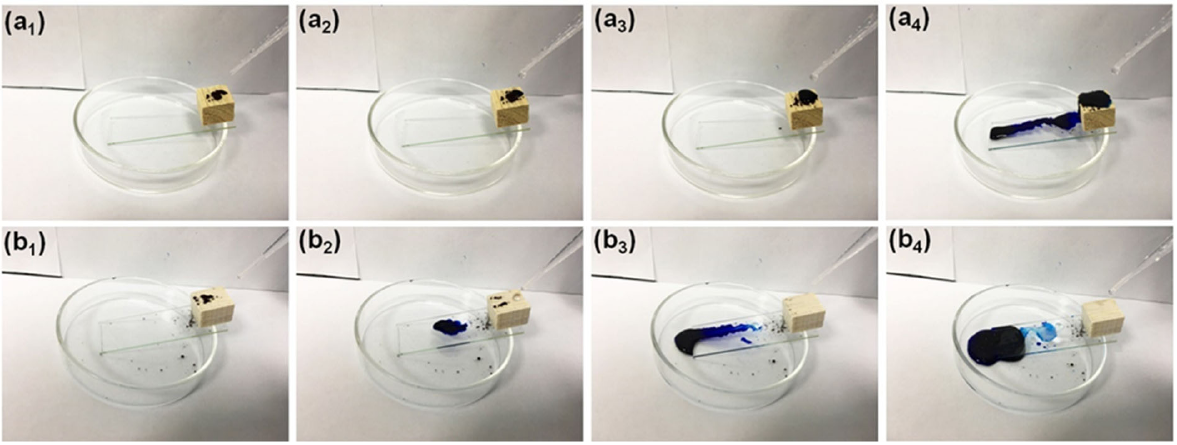
Figure 7. Wood self ‐ cleaning test before (a 1 ‐ a 4 ) and after the SiO 2 /PMHOS ‐ modified (b 1 ‐ b 4 )